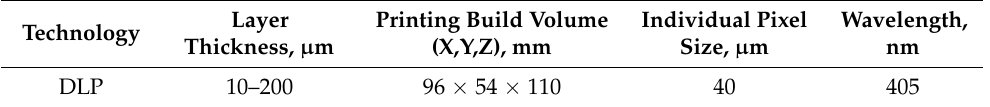
Table 1. Key parameters of the employed DLP printer.